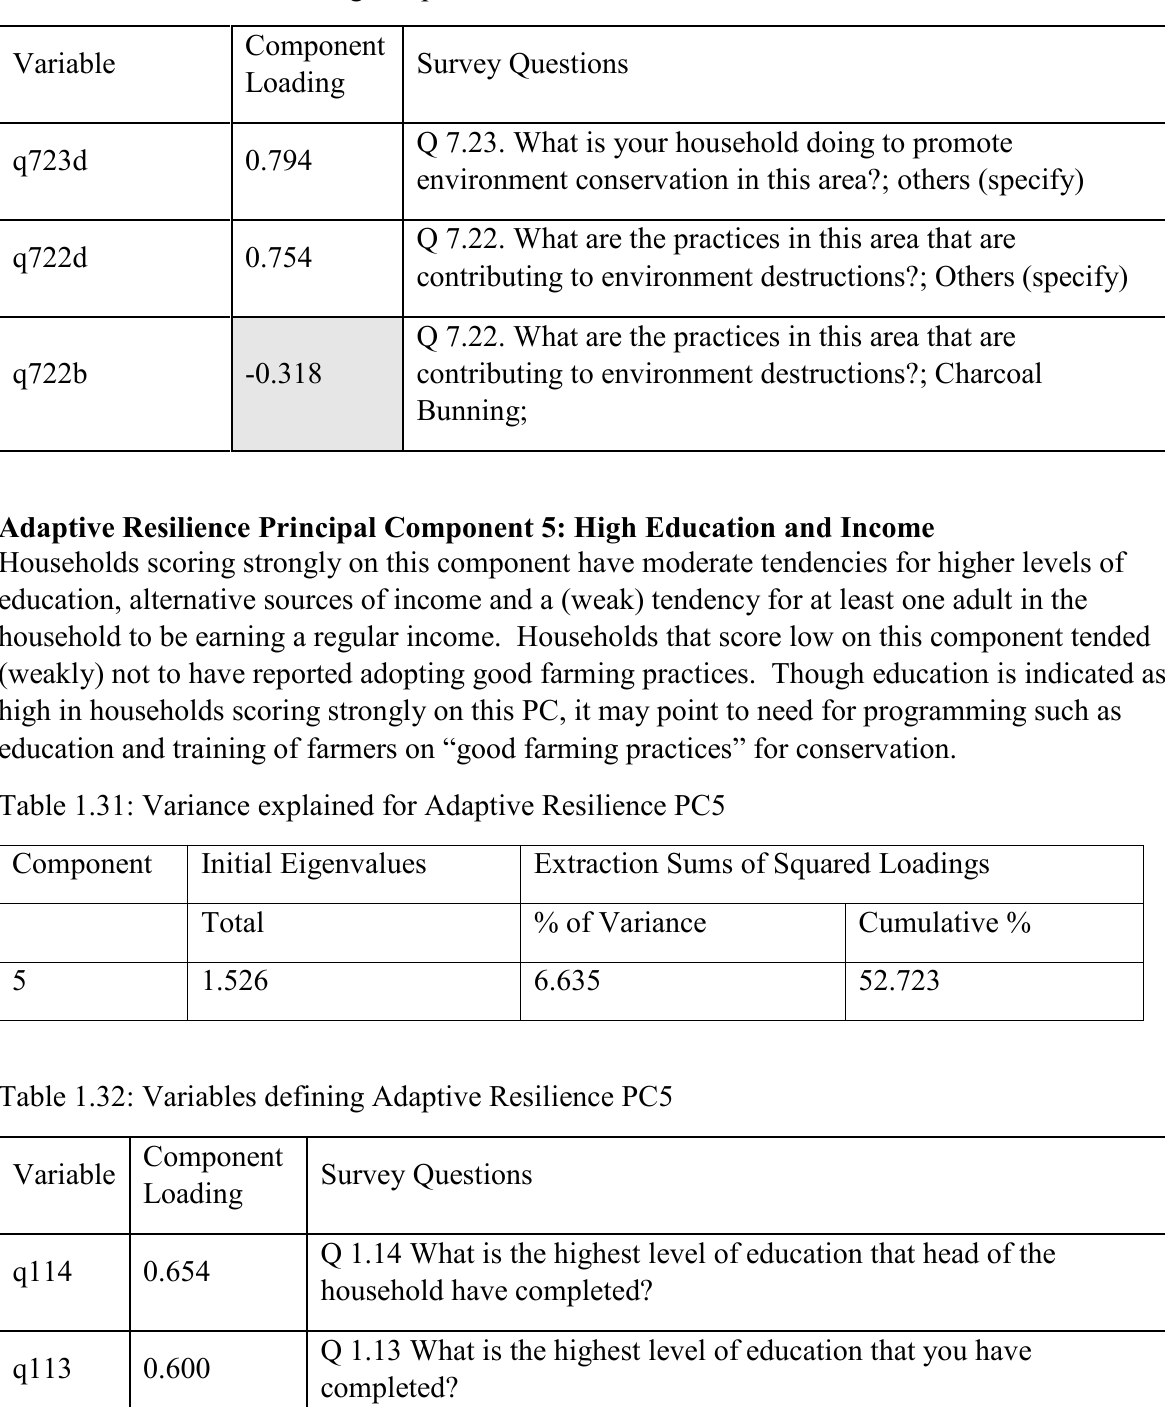
Table 1.30: Variables defining Adaptive Resilience PC4